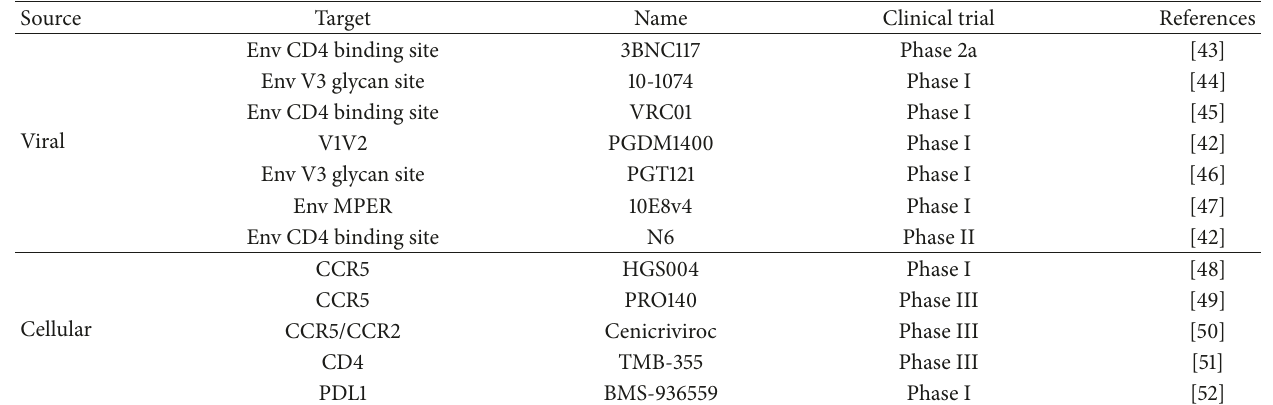
Table 2: Therapeutic antibodies that are being evaluated in the clinical